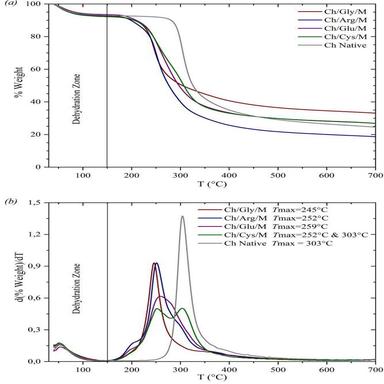
Thermogravimetric analyses of freeze-dried samples. (a) Weight loss as a function of the temperature; (b) Derivative of weight loss with respect to the temperature, as a function of the temperature. The temperatures at the maximum degradation rate (Tmax) are displayed.